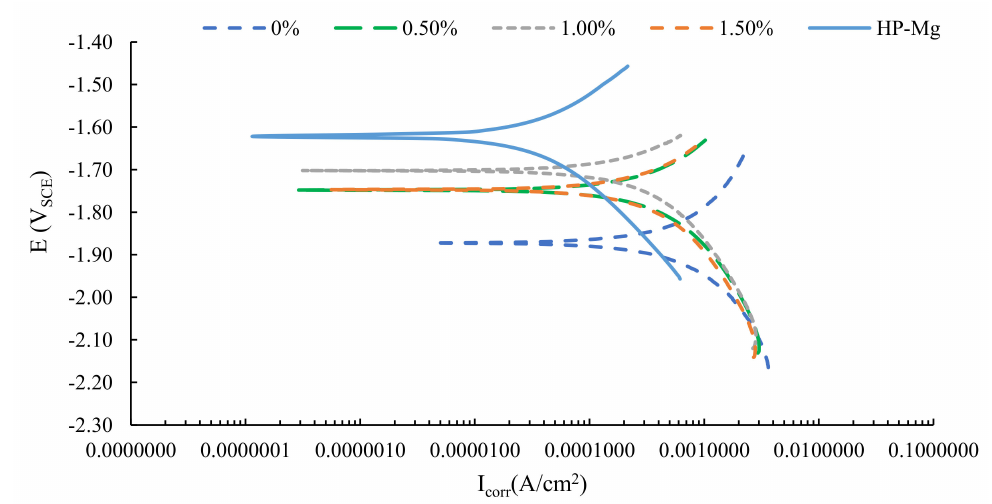
Figure 7. Tafel curves of Mg-SiO 2 nanocomposites vs. pure magnesium and